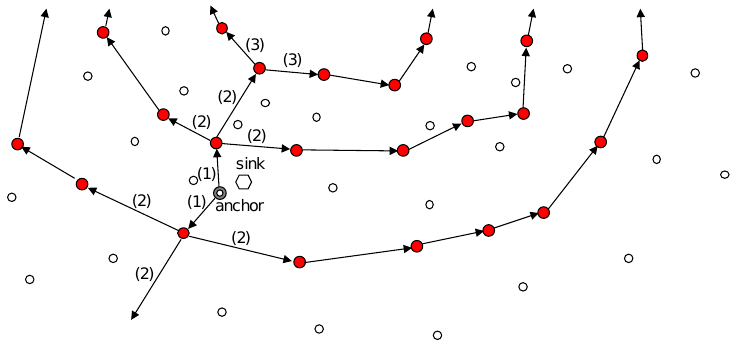
Figure 8. Advertisement of an anchor node’s